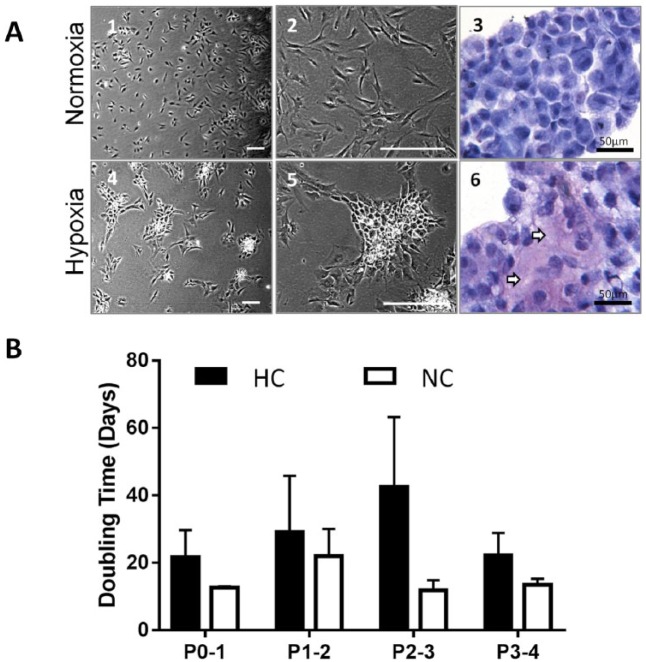
(A) Representative images from cells at passage 3 (P3) in normoxia (NC) (21% O2) and hypoxia (HC) (2% O2). (1 and 2) NC. (3) Cytospin stained with toluidine blue. (4 and 5) HC. (6) Cytospin stained with toluidine blue (arrows indicate glycosaminoglycan staining, purple metachromasia). (B) Doubling time (days) of NC (n = 4) and HC (n = 4). Bars represent the mean ± SD. Scale bars represent 200 µm unless otherwise stated.